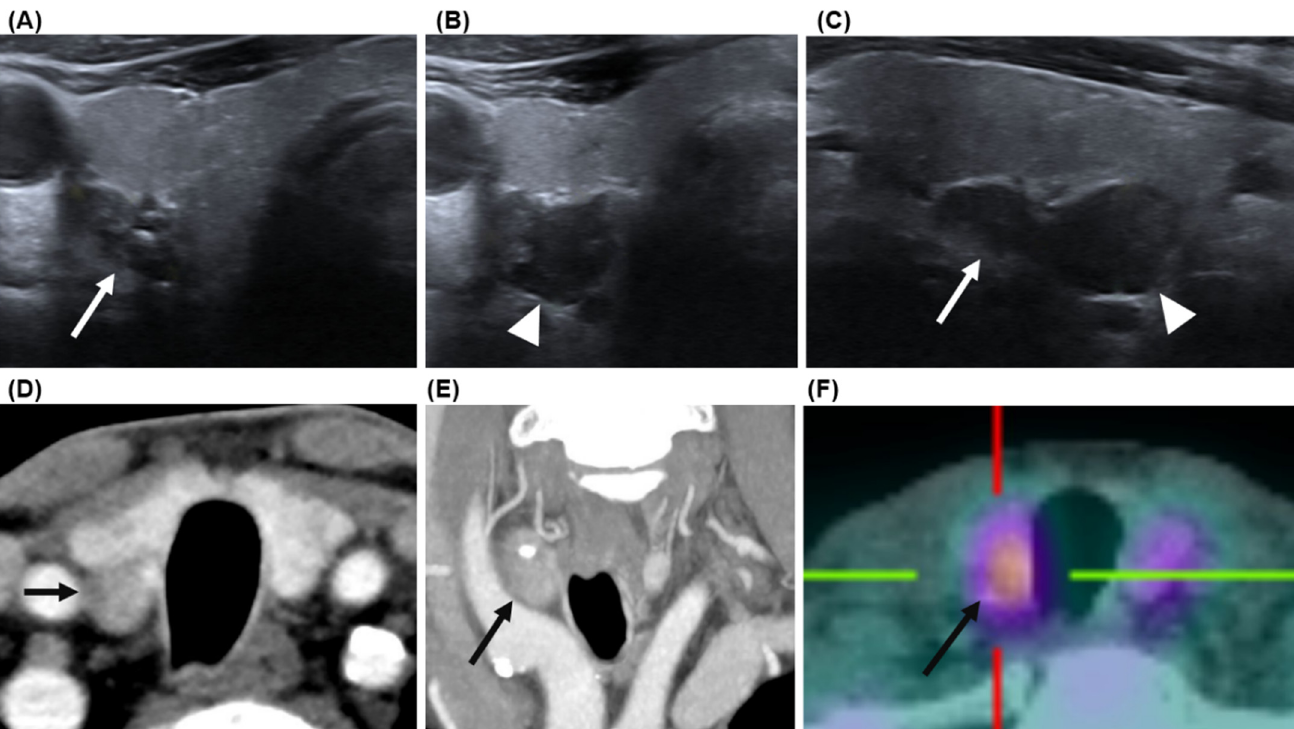
Figure 3. A 63-year-old man with secondary hyperparathyroidism. Ultrasound revealed ( A ) right superior parathyroid hyperplasia with internal calcification (white arrow) in axial view, ( B ) right inferior parathyroid hyperplasia (white arrowhead) in axial view, ( C ) right superior parathyroid hyperplasia (white arrow), and right inferior parathyroid hyperplasia (white arrowhead) in sagittal view. 4D-CT revealed fusion of right superior and inferior parathyroid hyperplasia (black arrow) in axial view ( D ) and in coronal view ( E ). Sestamibi SPECT/CT revealed fusion of right superior and inferior parathyroid hyperplasia (black arrow) in axial view ( F ).